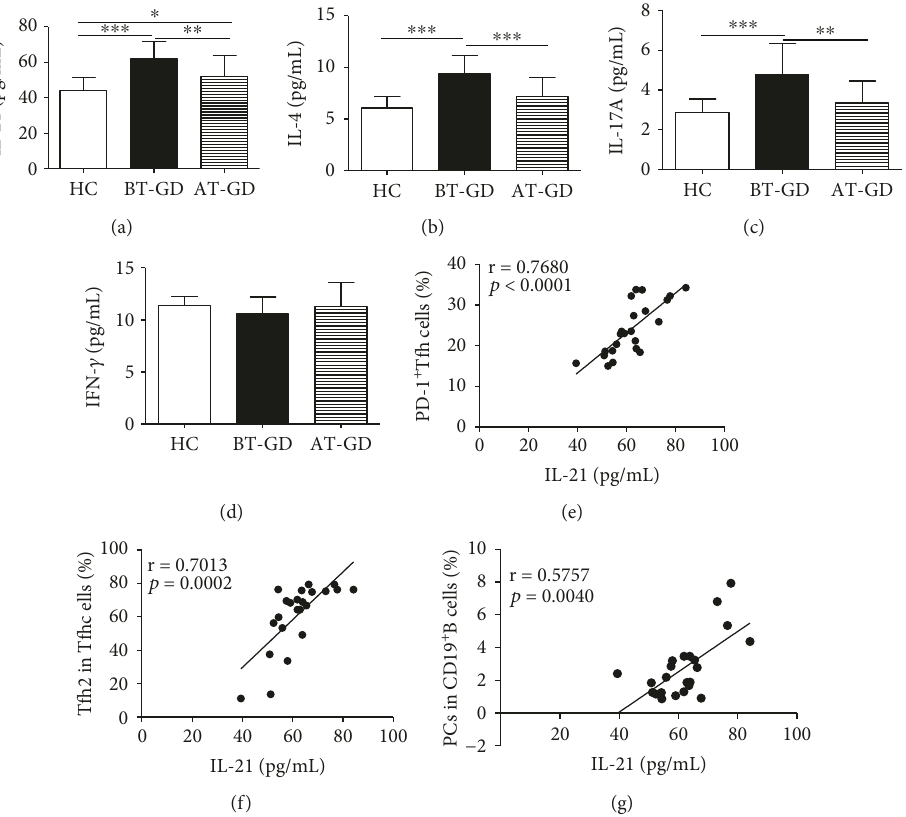
Figure 4: Plasma cytokine levels in GD patients. (a – d) The levels of plasma IL-21, IL-4, IL-17A, and IFN- γ were detected by ELISA in GD patients (BT: 23; AT: 16) and 20 HC. (e) Relation of PD-1 + Tfh with IL-21. (f) Relation of Tfh2 frequency with IL-21 level. (g) Relation of PC frequency with IL-21 level. ∗ p < 0 05 , ∗∗ p < 0 01 , and ∗∗∗ p < 0 001 ; ns: no signi fi cant di ff